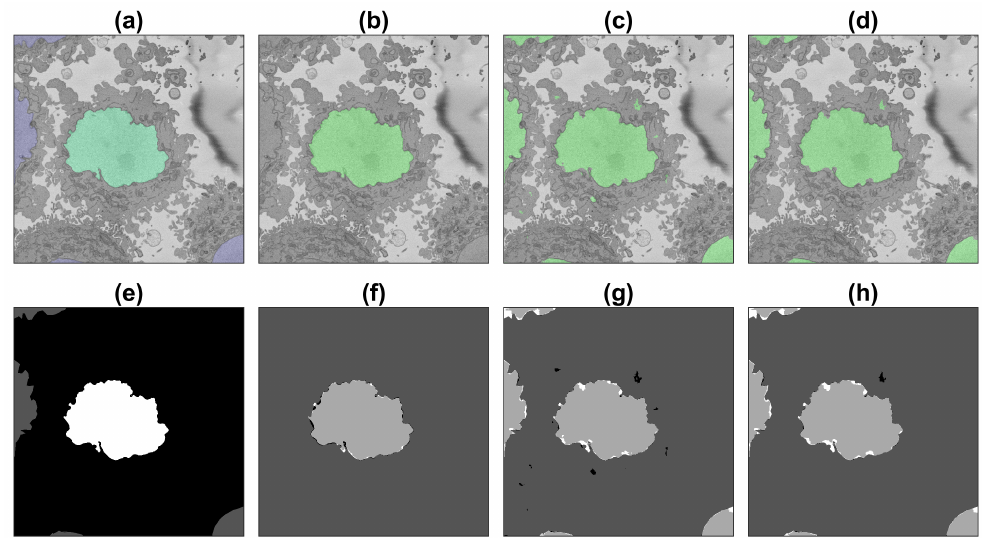
Figure 8. Illustration of the semantic segmentation of one slice (71/300) of the ROI with the image pro- cessing algorithm and U-Net (36,000 patches). Top row ( a – d ) show slice with results overlaid, bottom row ( e – h ) shows ground truth (GT) and results as classes. ( a , e ) GT, central nucleus in green/white whilst other nuclei in purple/grey and background in greyscale/black. ( b , f ) IP segmentation. ( c , g ) U- Net segmentation. ( d , h ) U-Net segmentation after post-processing. In ( f – h ) true positives = light grey, true negatives = darker grey, false positives = black, false negatives = white.